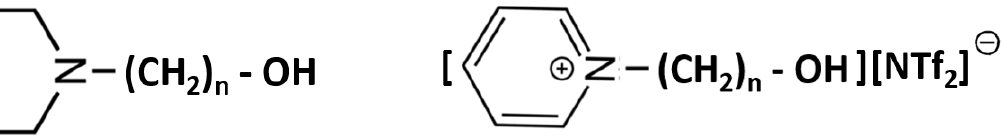
Figure 1. Structures of the hydroxyl-alkyl-piperidines ( left ) and hydroxyl-alkyl-pyridinium bis(trifluoromethylsulfonyl)imides = [N-C n OH-Py][NTf 2 ] ( right ). The number of the methylene groups n = 2, 3, and 4.